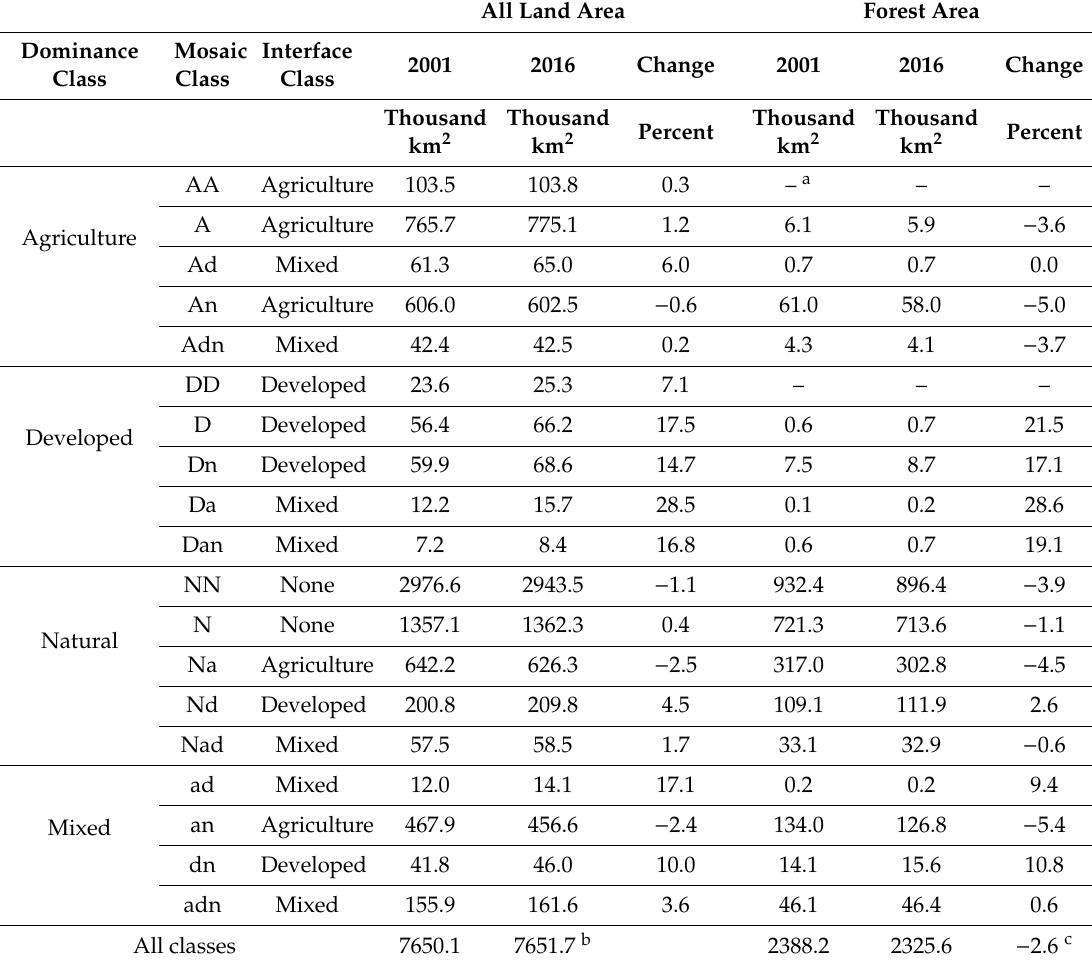
Table 2. CONUS change of all land area, and of forest area only, from 2001 to 2016, by mosaic class. All Land Area